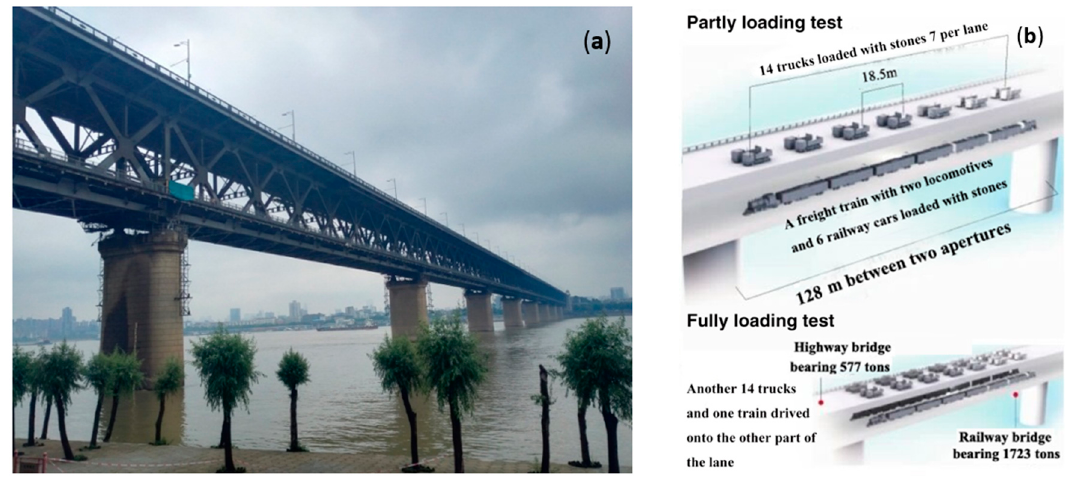
Figure 5. ( a ) Wuhan Yangtze River Bridge; and ( b ) the schematic of the static loading test.